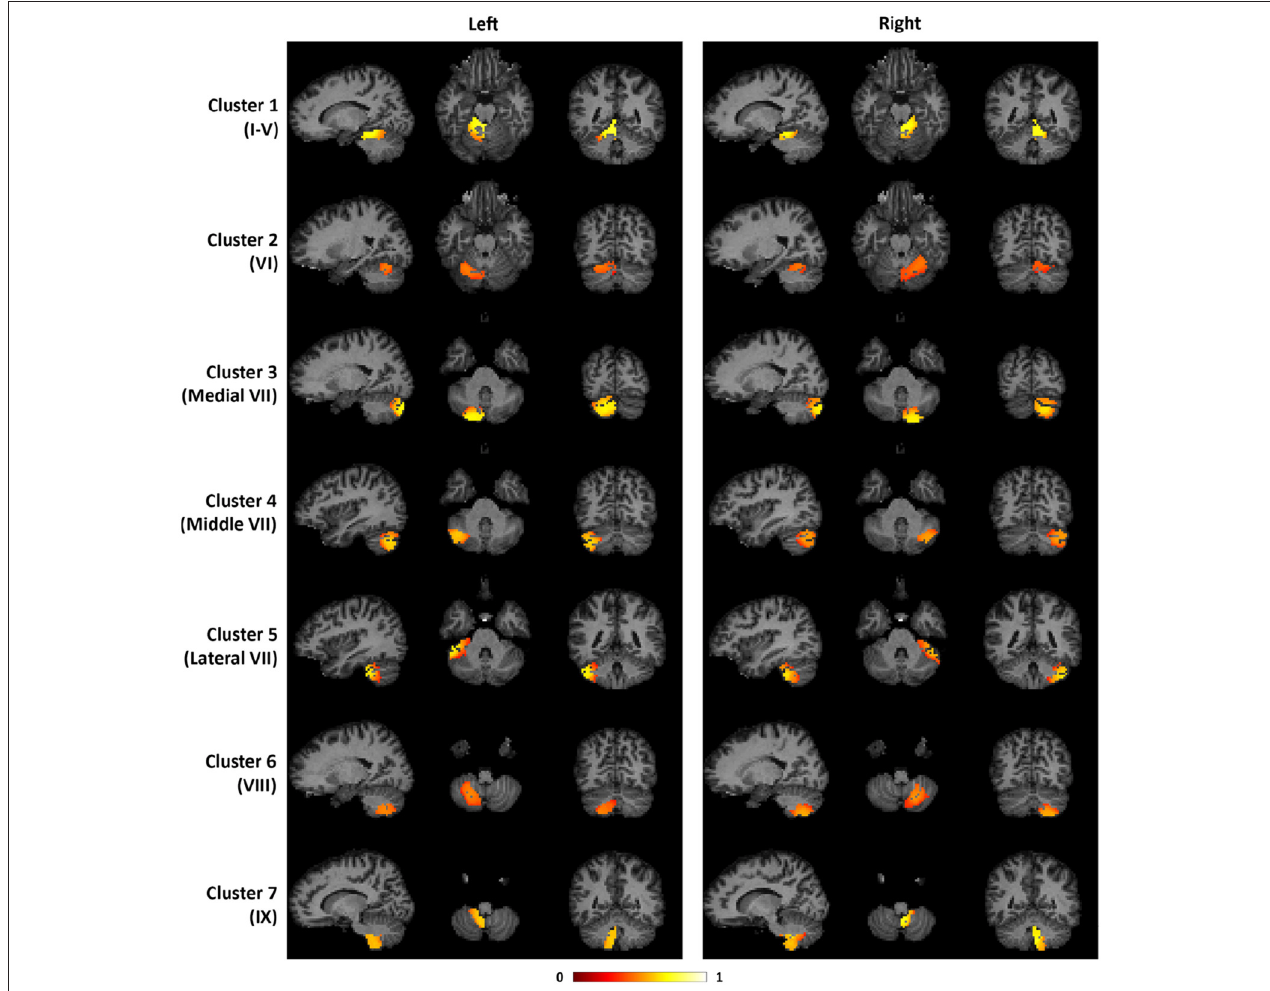
FIGURE 6 | The probability maps for the seven cerebellar clusters. The left half of the figure displays the seven clusters in the left cerebellum, while the right half displays the seven clusters in the right cerebellum. From top to bottom, the seven clusters are located in the following anatomical lobules: I-V; VI; Medial VII; Middle VII; Lateral VII; VIII;